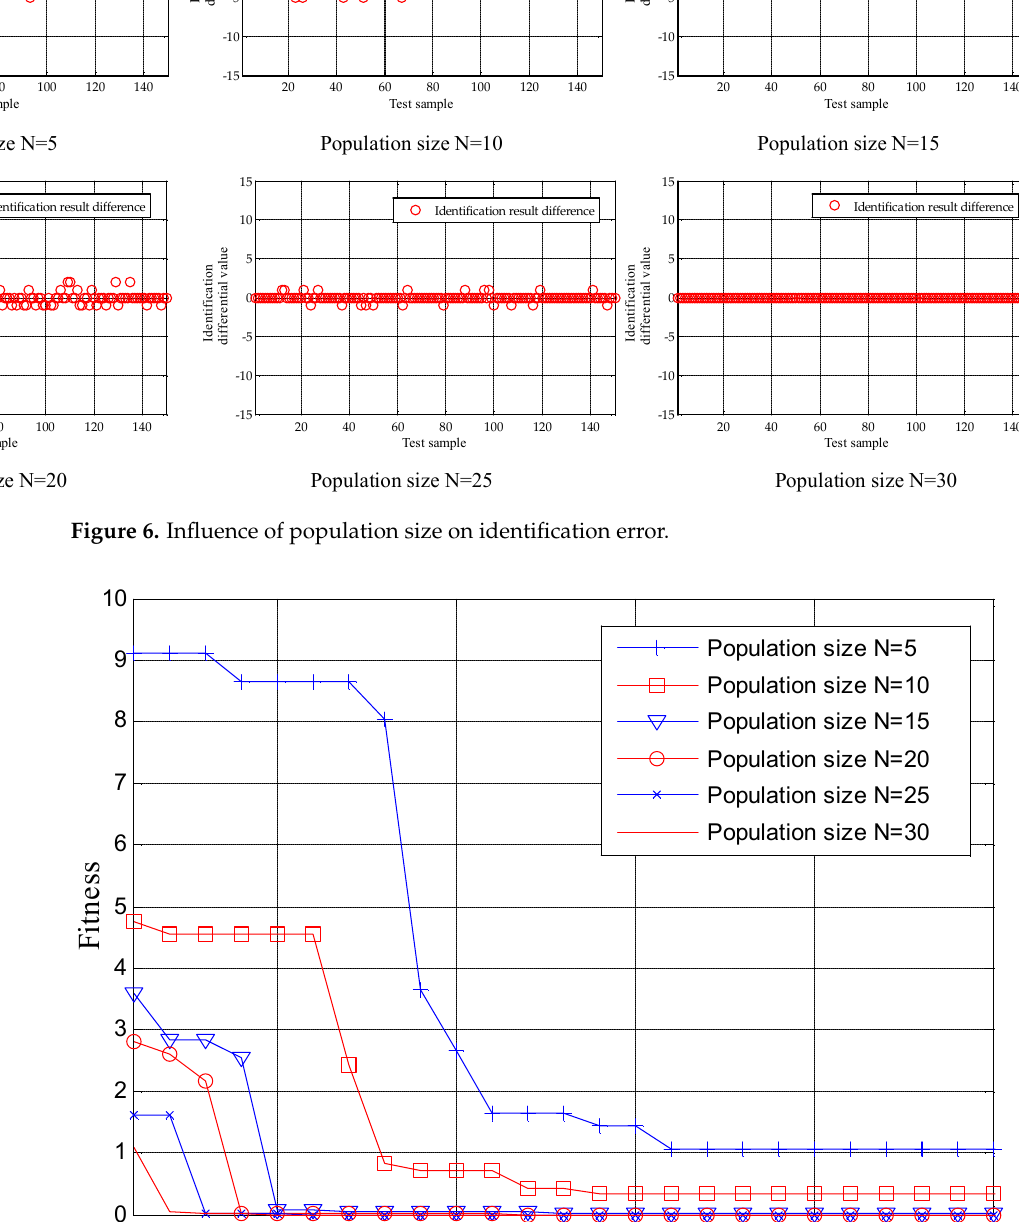
Figure 6. Influence of population size on identification error.